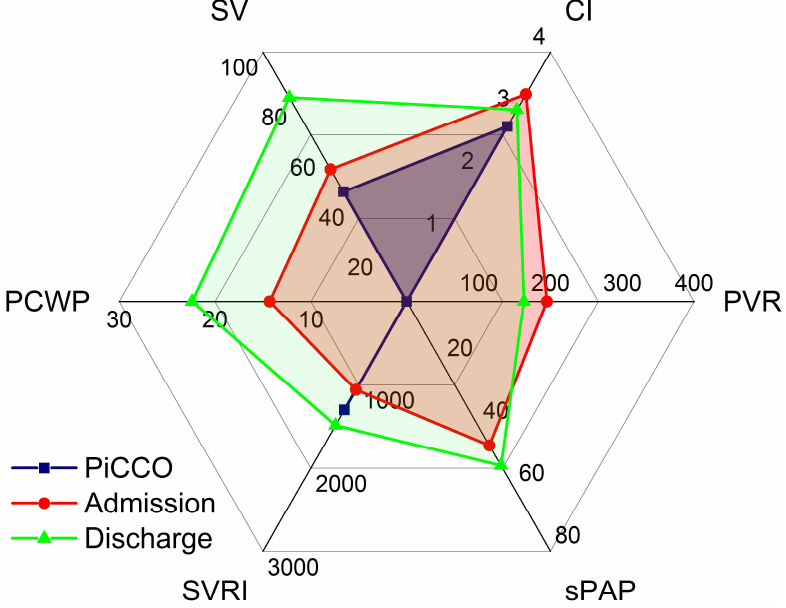
Figure 4. PiCCO misinterpreting significant tricuspid regurgitation as cardiogenic shock. Haemo- dynamic profiles on admission (red) and at discharge (green). Blue areas depict an inaccurate PiCCO measurement owing to significant tricuspid regurgitation. CI: cardiac index [L · min − 1 · m − 2 ]; SV: stroke volume [mL]; PCWP: pulmonary capillary wedge pressure [mmHg]; SVRI: systemic PVR: pulmonary vascular resistance [dyn · s · cm − 5